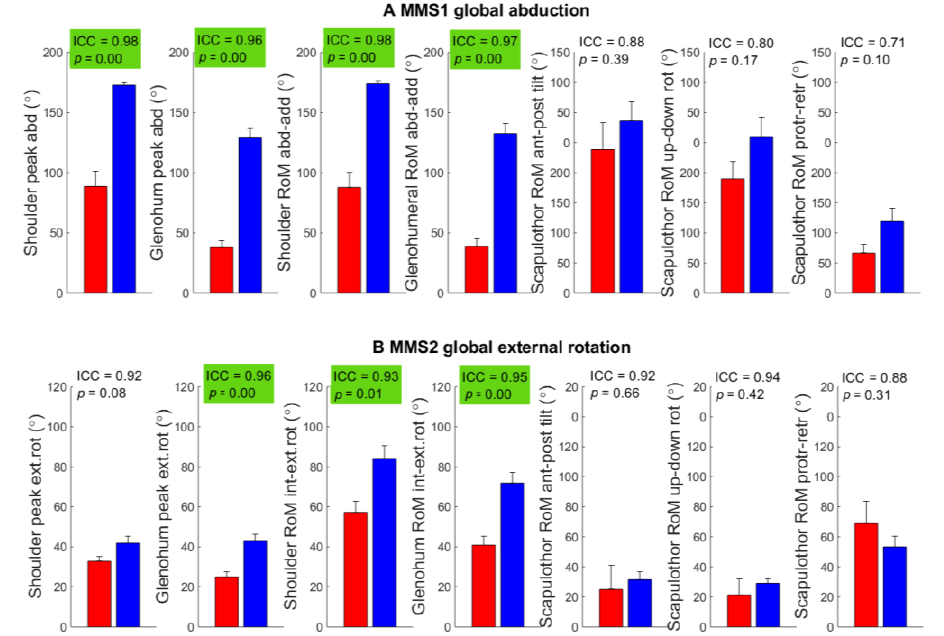
Figure 5. Outcome measures from the assessment of two tasks from the modified Mallet scale (MMS); ( A ) global abduction and ( B ) global external rotation. Group mean and standard error of mean are illustrated (BPBI: red left bar, control: blue right bar). ICC from test – retest reliability and p-values from t- tests are shown in the upper right corner of each subplot and are highlighted green for outcome scores with both good test – retest reliability (ICC > 0.75) and a significant group difference ( p < 0.05).